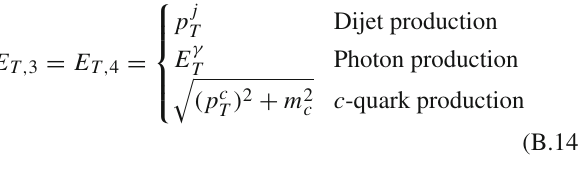
photon pseudo-rapidity η CM bins in the CoM frame. The band in the theory prediction indicates the PDF uncertainty, and the bottom panels display the ratio to the central theory. No scale uncertainties are con- √ s = 8 . 16 TeV. Results sidered in this comparison. The value of the χ 2 to this dataset for both γ nNNPDF3.0 is also indicated in the for three T